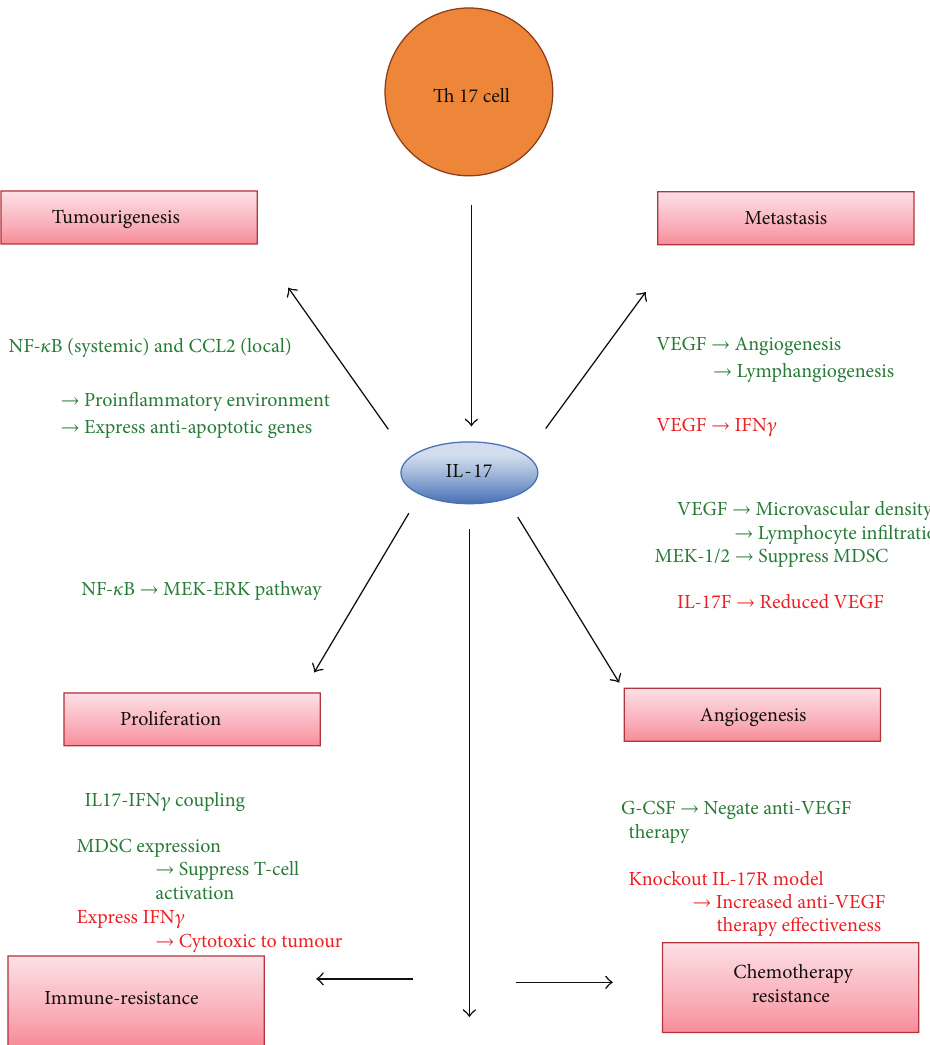
Figure 1: Diagram summarising the reviewed mechanisms by which IL-17 induces (green) or inhibits (red) different aspects of cancer pathophysiology. IL17: interleukin 17; VEGF: vascular endothelial growth factor; NF- 𝜅 B: nuclear factor kappa-light-chain-enhancer of activated B cells; CCL2: chemokine (C-C motif) ligand 2; IFN 𝛾 : interferons 𝛾 ; G-CSF: granulocyte colony stimulating